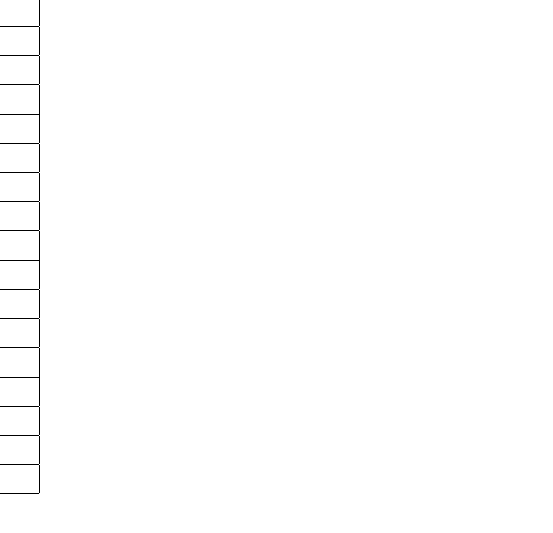
Table 2. Model parameter